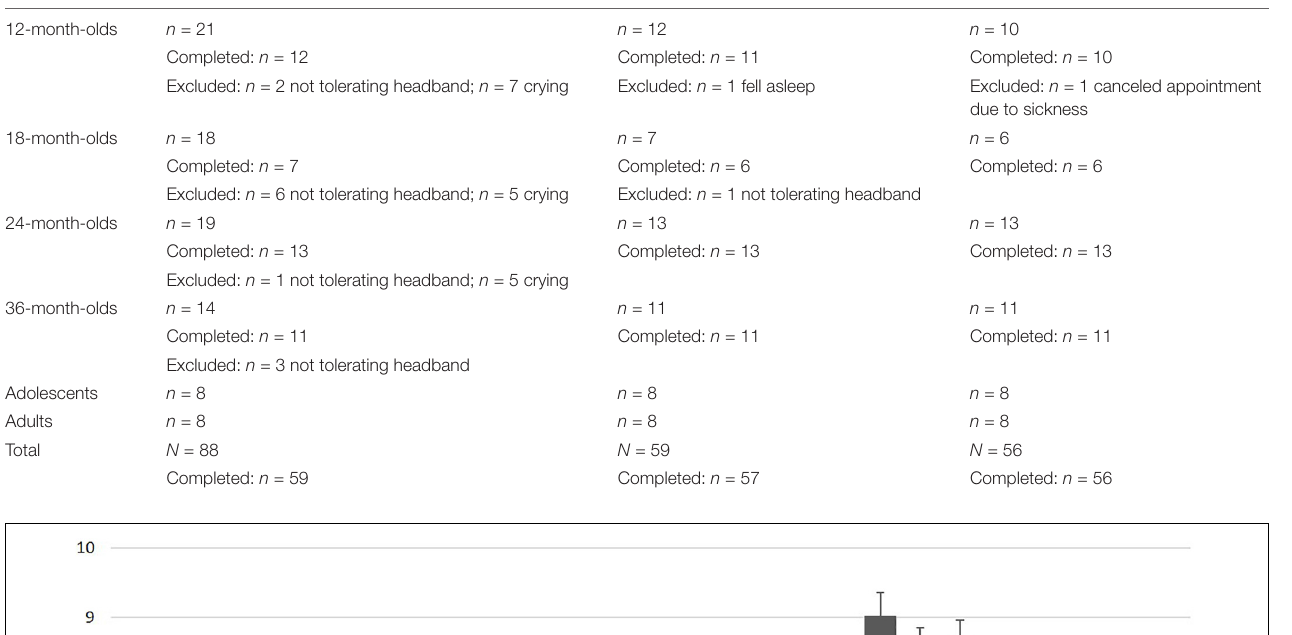
TABLE 1 | Number of participants per age group that participated (first rows) and that completed (second rows) each session, including reasons for exclusions. Age group